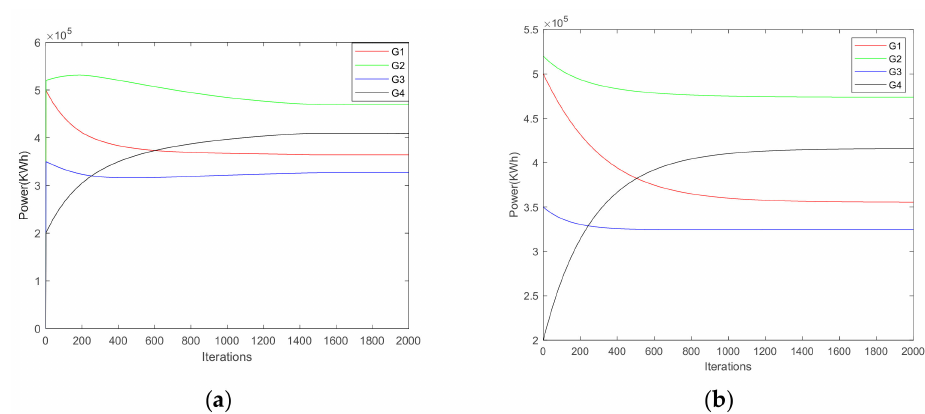
Figure 11. The output power distribution. ( a ) Fixed-time consistency of the power state at the random delay; ( b ) Classic consistency in the power state at the random